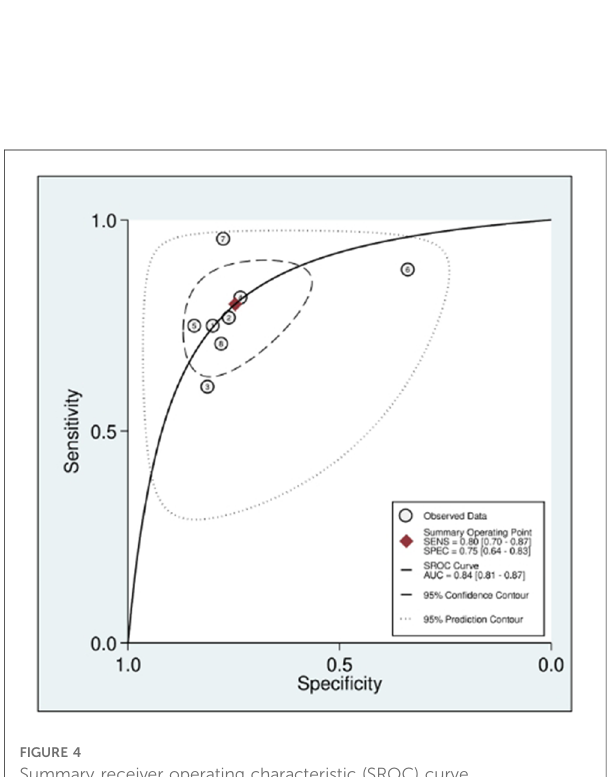
FIGURE 4 Summary receiver operating characteristic (SROC) curve.